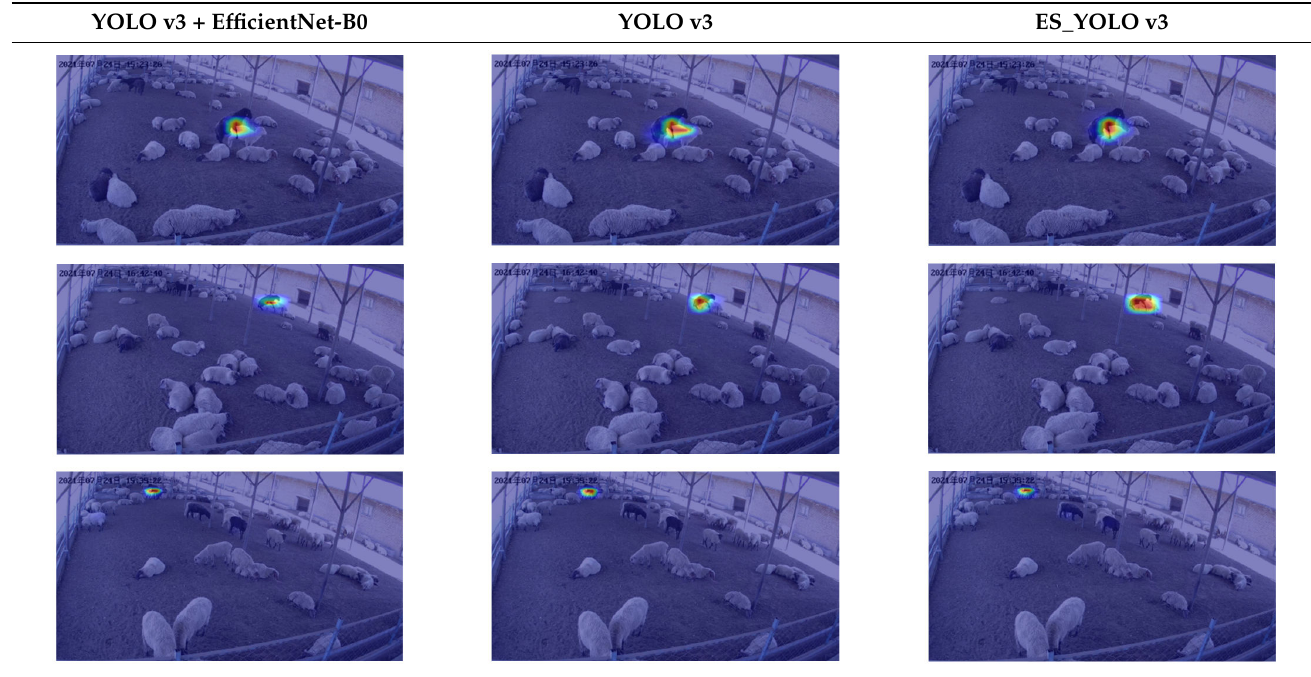
Figure 12. Analysis of remote detection results: ( a ) Original image; ( b ) YOLO v3 + EfficientNet-B0 recognition effect; ( c ) YOLO v3 recognition effect; ( d ) ES_YOLO v3 recognition effect. The Chinese in the upper left corner of the image is the date of the video recording, in order of year, month and day. Table 5. Attention heat maps of YOLO v3 + EfficientNet-B0, YOLO v3 and ES_YOLO v3 models in ewe estrus behavior detection. The Chinese in the upper left corner of the image is the date of the video recording, in order of year, month and